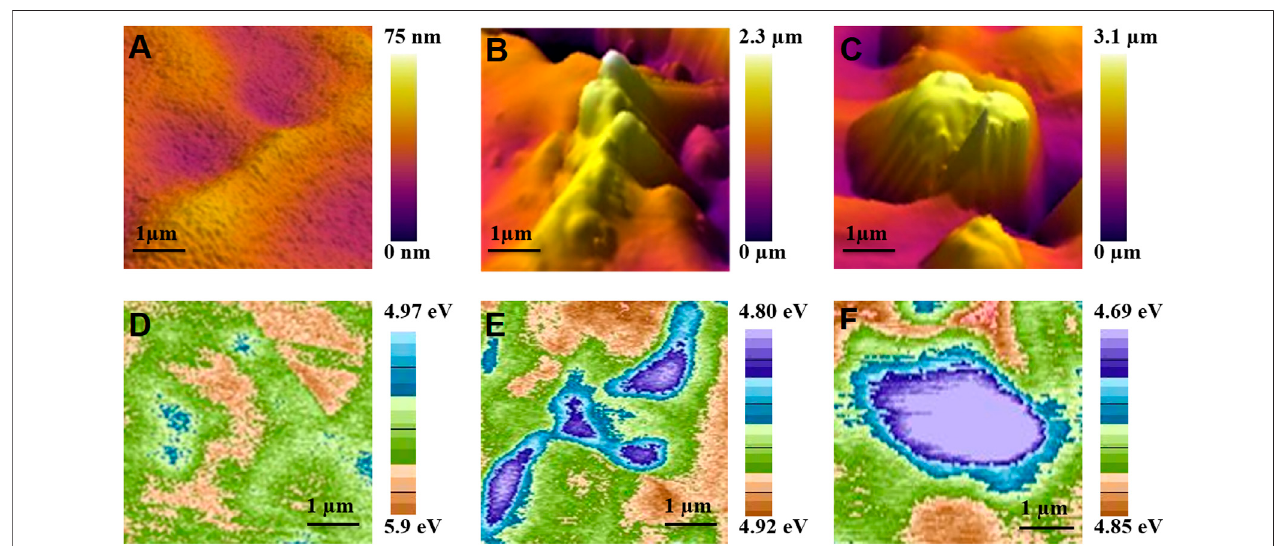
FIGURE 4 | AFM topography (5 μ m × 5 μ m scan area) of (A) pristine Cu sheet, 2 keV Ar + bombarded Cu sheet at normal incidence with fl uence; (B) 3.2 × 10 18 cm − 2 and (C) 4.7 × 10 18 cm − 2 . KPFM image showing thesurface work function modi fi cation (D) pristine and correspondingCu irradiated by Ar at fl uence (E) 3.2 × 10 18 cm − 2 and (F) 4.7 × 10 18 cm − 2